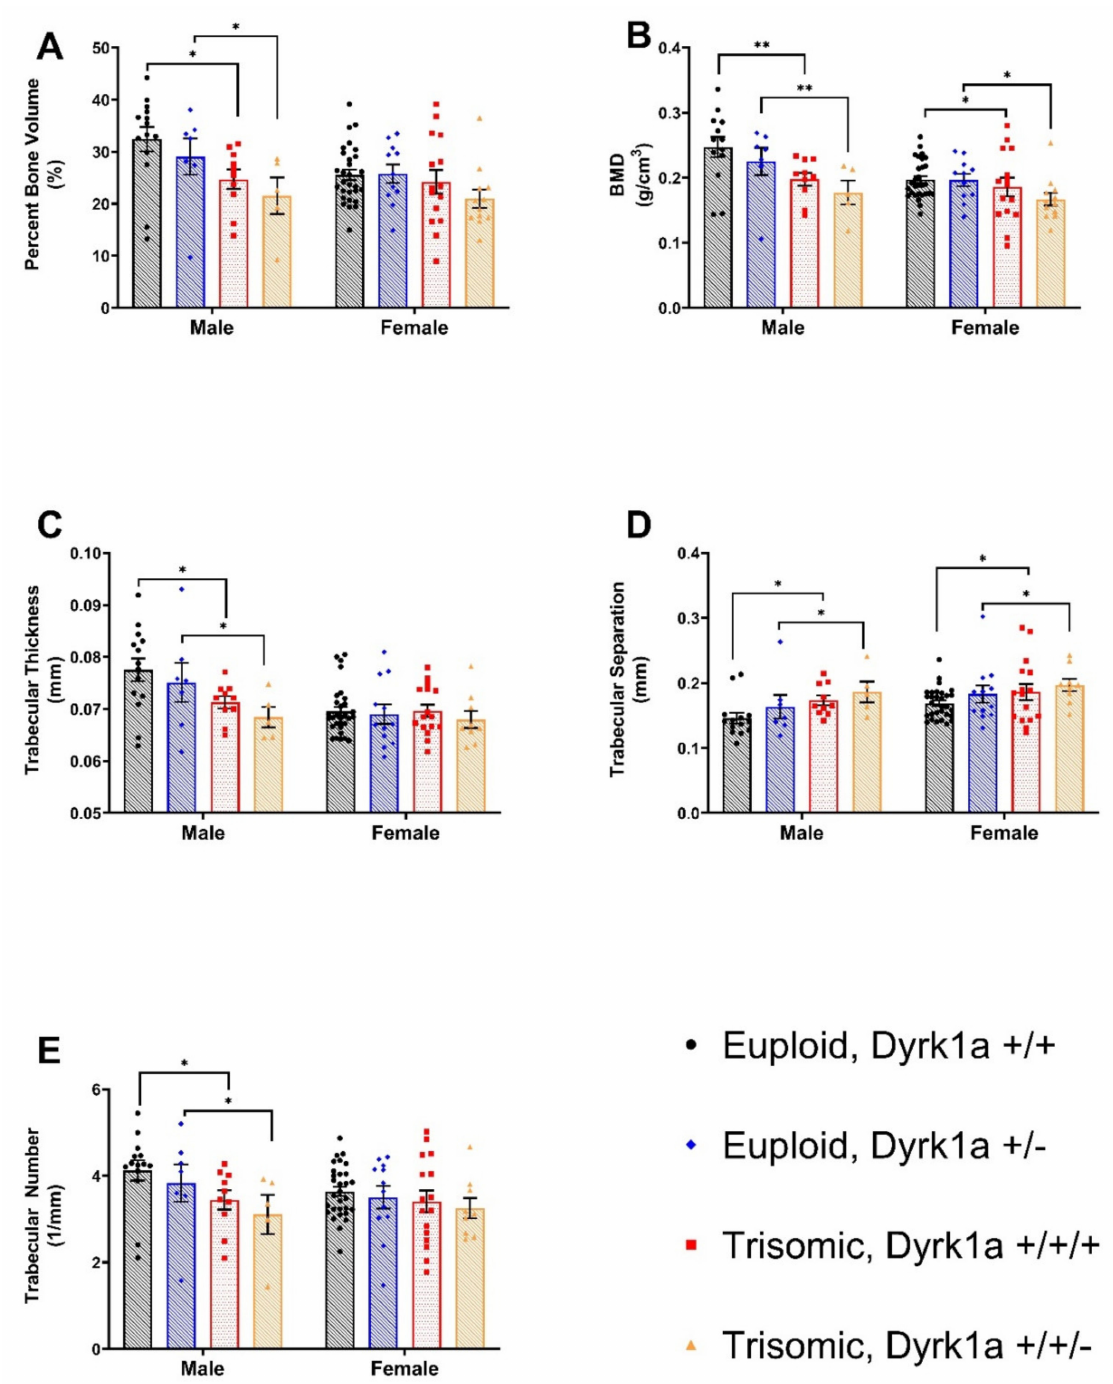
Figure 1. Trabecular architecture differs between male and female Euploid and Ts65Dn animals at six weeks of age ( B – D ). ( A ) Percent Bone Volume (BV/TV); Main effect of ploidy for male and female. ( B ) Bone mineral density (BMD); Main effect ploidy for male and female. ( C ) Trabecular Thickness (Tb.Th) Main effect of ploidy for male mice. ( D ) Trabecular separation; Main effect of ploidy for male and female. ( E ) Trabecular Number (Tb.N) Main effect of ploidy for male mice. Mean ± SD; bars between groups of mice denote significance; p -value 0.1234 (ns); 0.0332 (*); 0.0021